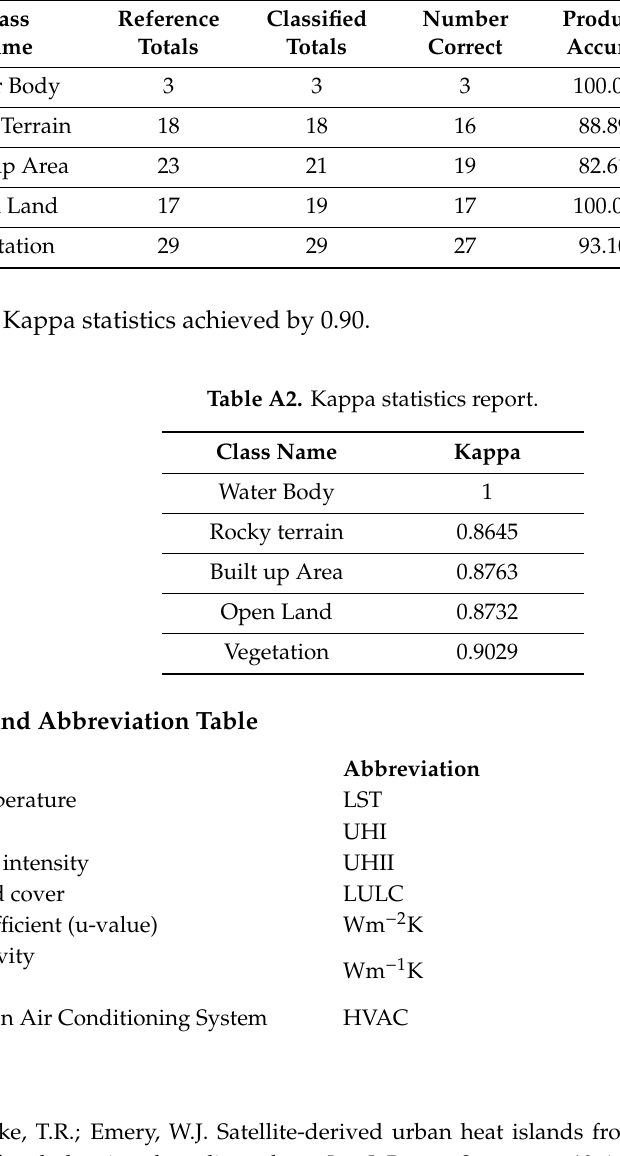
Table A1. Overall accuracy assessment of LULC for the month of March.